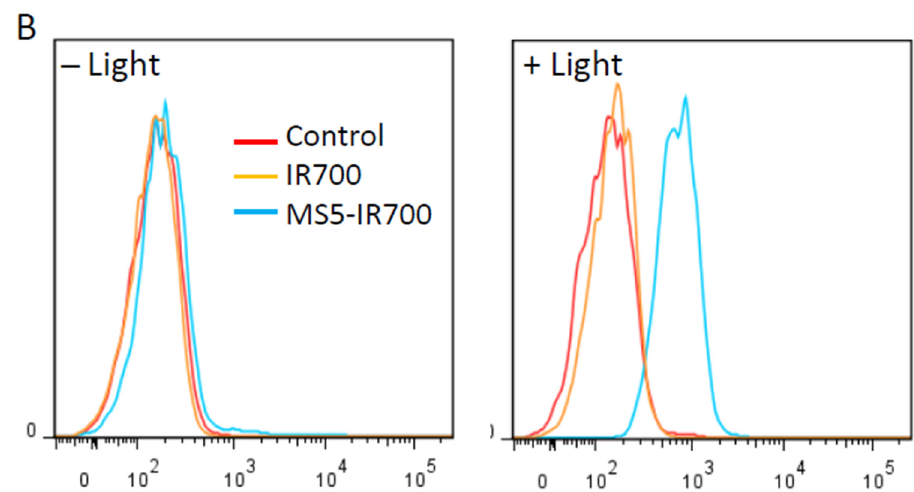
Figure 8. ROS induction. Cellular ROS levels were measured using the redox-sensitive indicator H2DCFDA. PC3 cells were labeled with H2DCFDA, incubated with the test molecules, washed, exposed to NIR light (35 J/cm 2 at a power density of 35 mW/cm 2 ), and then placed at 37 °C. After 6 ( A ) or 20 ( B ) h, the cells were analyzed by flow cytometry to detect fluorescent cells. Data are representative of 3 independent experiments.